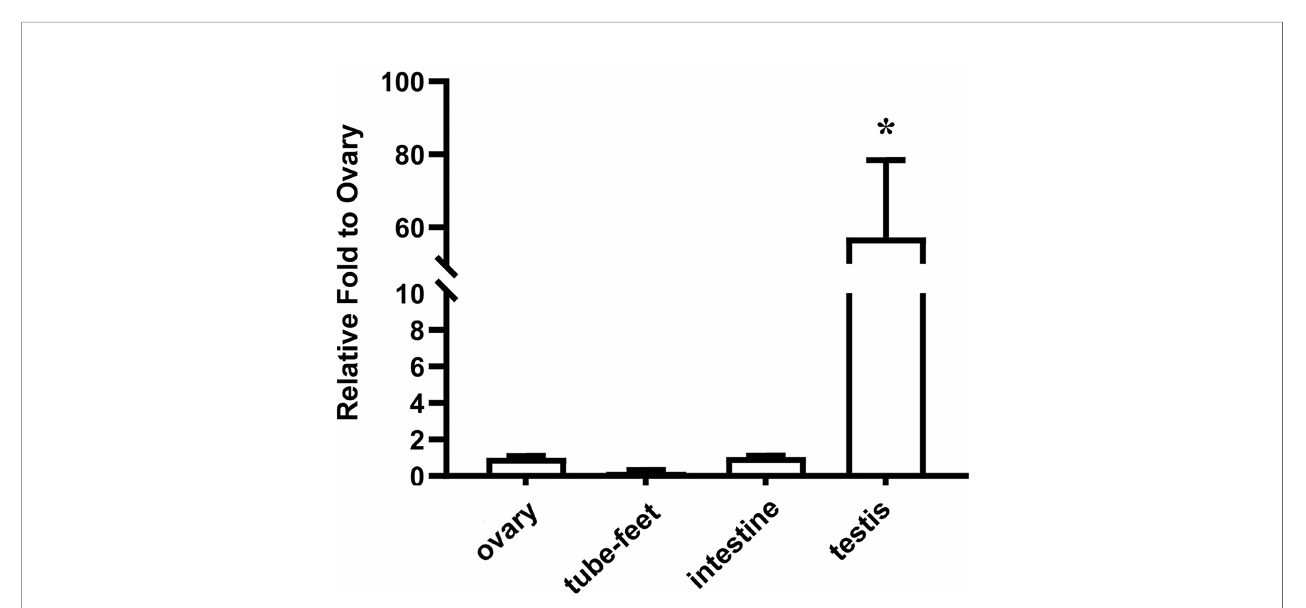
FIGURE 3 | Expression pattern of spata4 mRNA in S. intermedius. 18S was used as the control. Each bar represents mean ± standard deviation (SD) ( n = 3). One- way ANOVA was used to determine statistical analysis. Asterisks (*) indicate signi fi cant differences ( p ≤ 0.05).